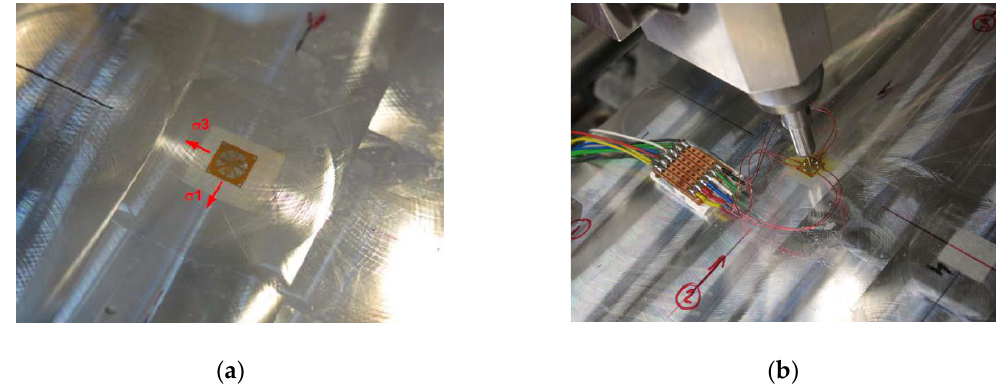
Figure 6. Detail of installation of strain gauge at measuring position ( a ) and incremental drilling ( b ).